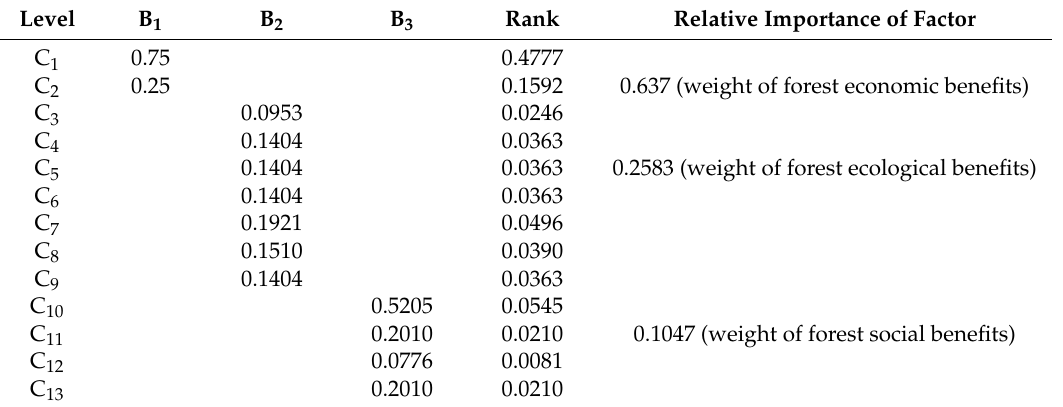
Table 8. The analytic hierarchy process (AHP) method used in the income analysis of forest in Yanqing